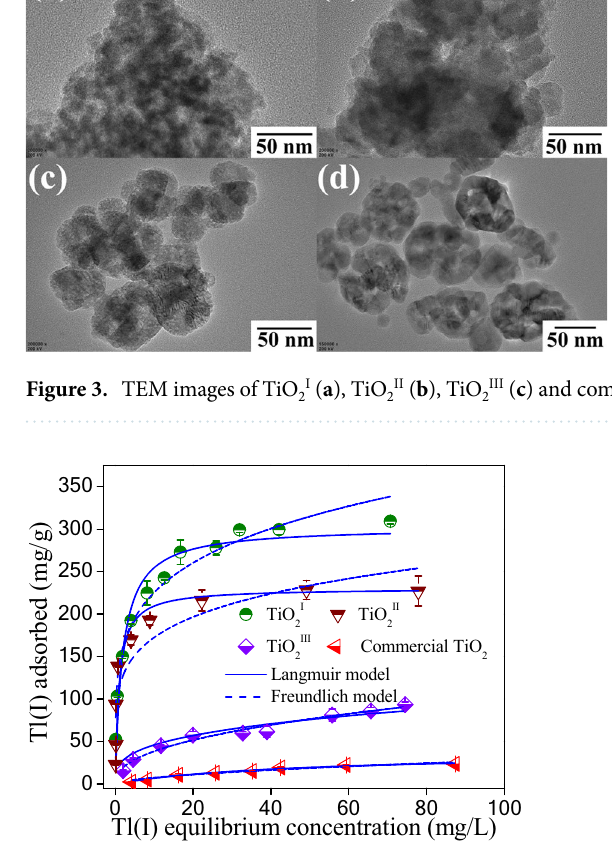
Figure 4. Adsorption isotherms of Tl(I) on the synthesized and commercial TiO 2 . Experiment conditions: Adsorbent dosage = 0.2 g/L; pH = 7.0 ± 0.1 and T = 25 ± 1